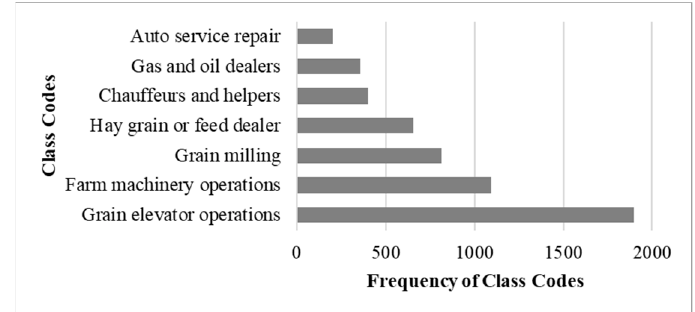
Figure 3. Frequency of occupation class codes in grain elevators.